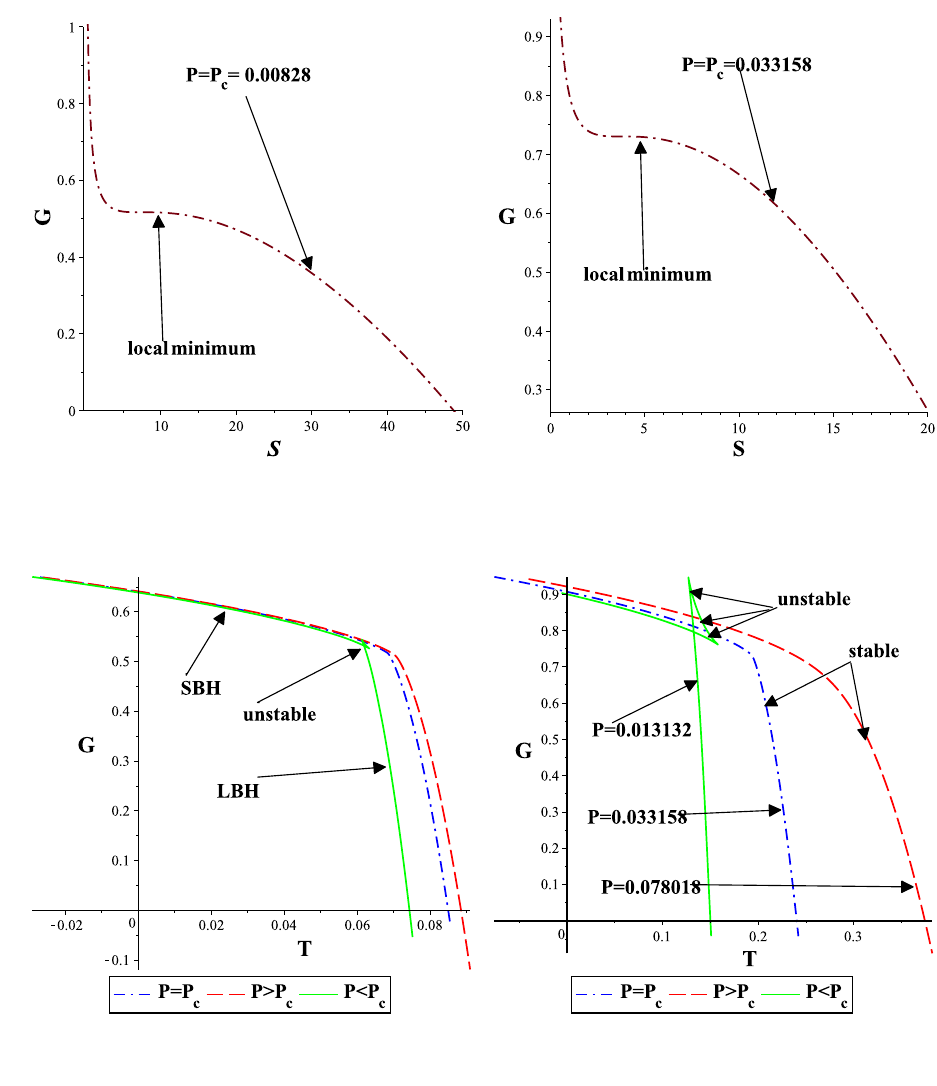
Fig. 15 G versus S with e = 0 . 2, g = 0 . 6. Left panel: a 2 = 1 and right panel: a 2 = 2